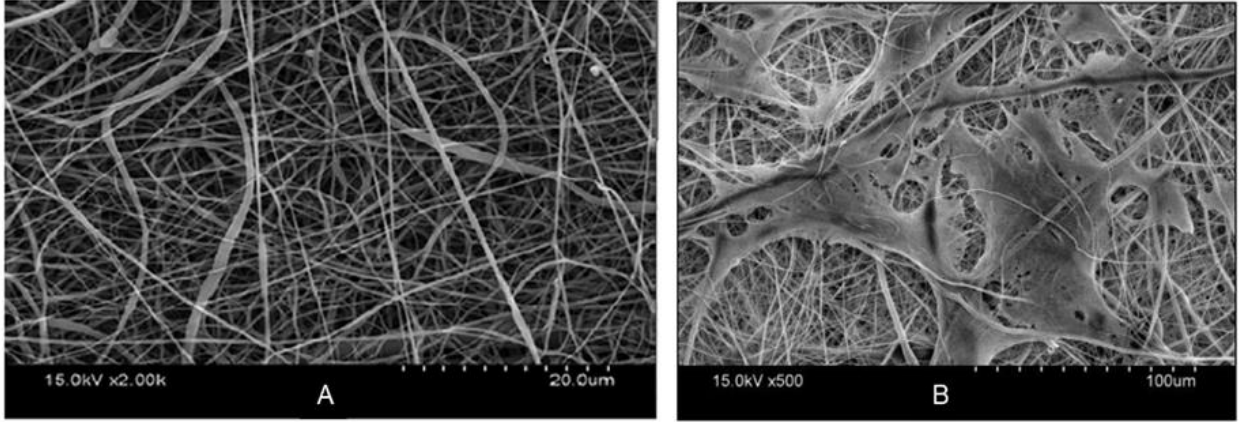
Figure 16. SEM images showing electrospun PVDF/PANI blends [207] ( A ) before and ( B ) after 3- day culture of MC3T3 cells. Reprinted with permission from Ref. [207]. Copyright 2020, John Wiley &